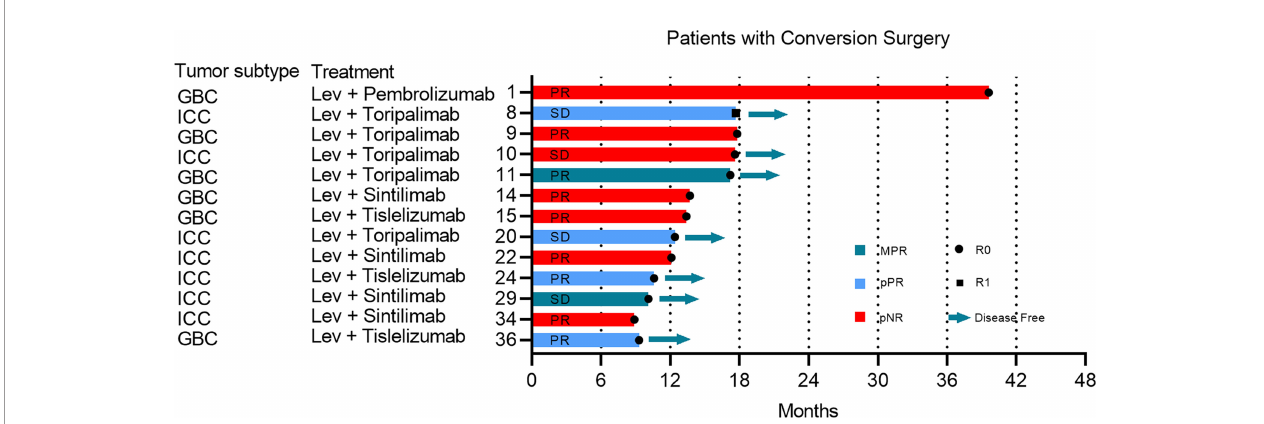
FIGURE 2 | The complete course of conversion treatment and post-surgery outcome. No more than 10% of viable tumor in the treated tumor beds were considered to have had a major pathological response (MPR). Partial pathologic response (pPR) was de fi ned as more than 10% and less than 50% residual viable tumor by chemotherapy criteria while pathologic nonresponse (pNR) was de fi ned as more than 50% residual viable tumor. The preoperative radiographic response of each patient was marked in the bar. ICC, intrahepatic cholangiocarcinoma; GBC, gallbladder cancer; PD, progressive disease; PR, partial response; SD, stable disease; Lev,